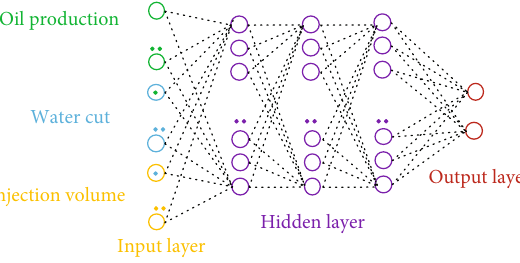
Figure 1: Diagram of the designed network structure of